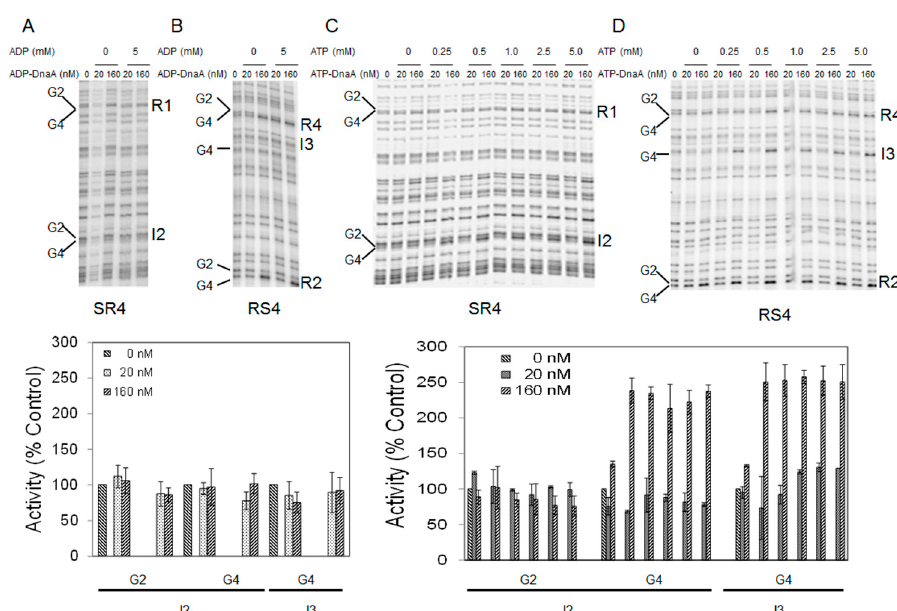
Figure 5. Adenine nucleotide-induced conformational changes are required for pre-RC assembly at E. coli chromosomal origin. ( Top ) ADP-DnaA or ATP-DnaA at 20 and 160 nM were incubated with oriC DNA in the absence or presence of 5 mM ADP and absence or presence of 0.25, 0.5, 1.0, 2.5 and 5 mM ATP, respectively and modifications to DMS footprint patterns caused by bound protein were assessed. Sites R1, I2, R4, I3, R2 and the guanines at position 2 and 4 within each site are marked. Primer extension was carried out using primer SR4 ( A , C ) or primer RS4 ( B , D ) [29]. Note: I3 lacks a guanine at position 2; ( Bottom ) Band intensities at positions G2 and G4 for low affinity sites I2 and I3 are plotted relative to the intensity of the corresponding band in the no protein (0 nM) control Lane . Inclusion of ADP or ATP is indicated. Error bars denote standard deviation from three independent experiments.